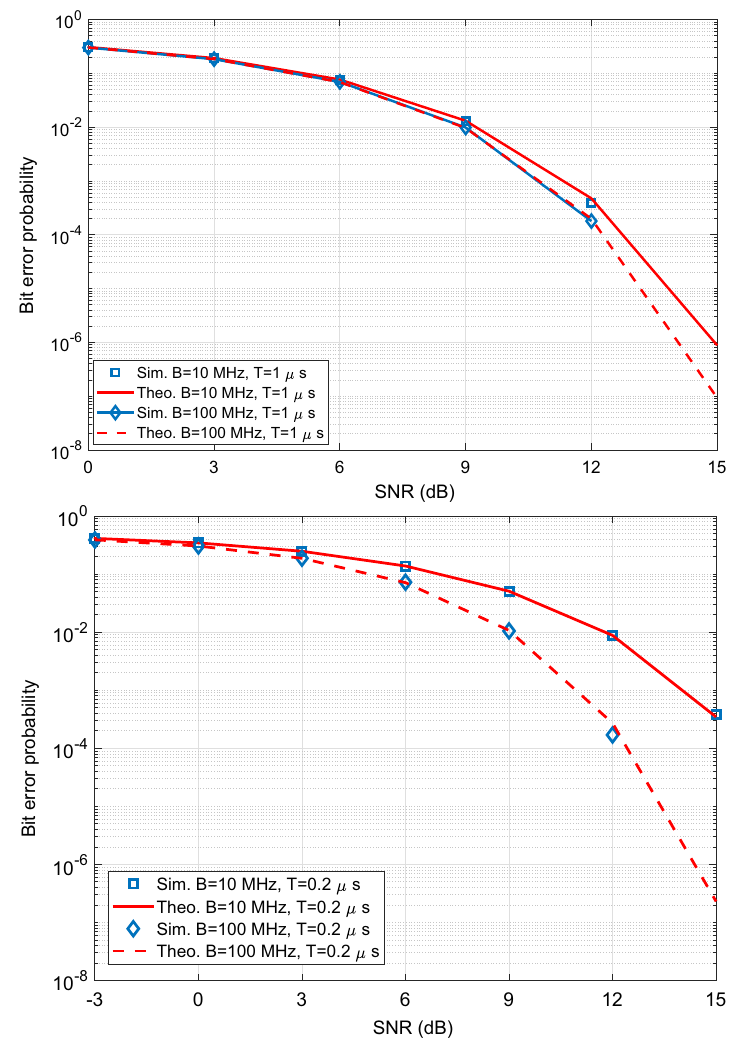
Fig. 3 Bit error probability versus SNR for different B and T : a-(top)) L c = 300 , b-(bottom)) L c =